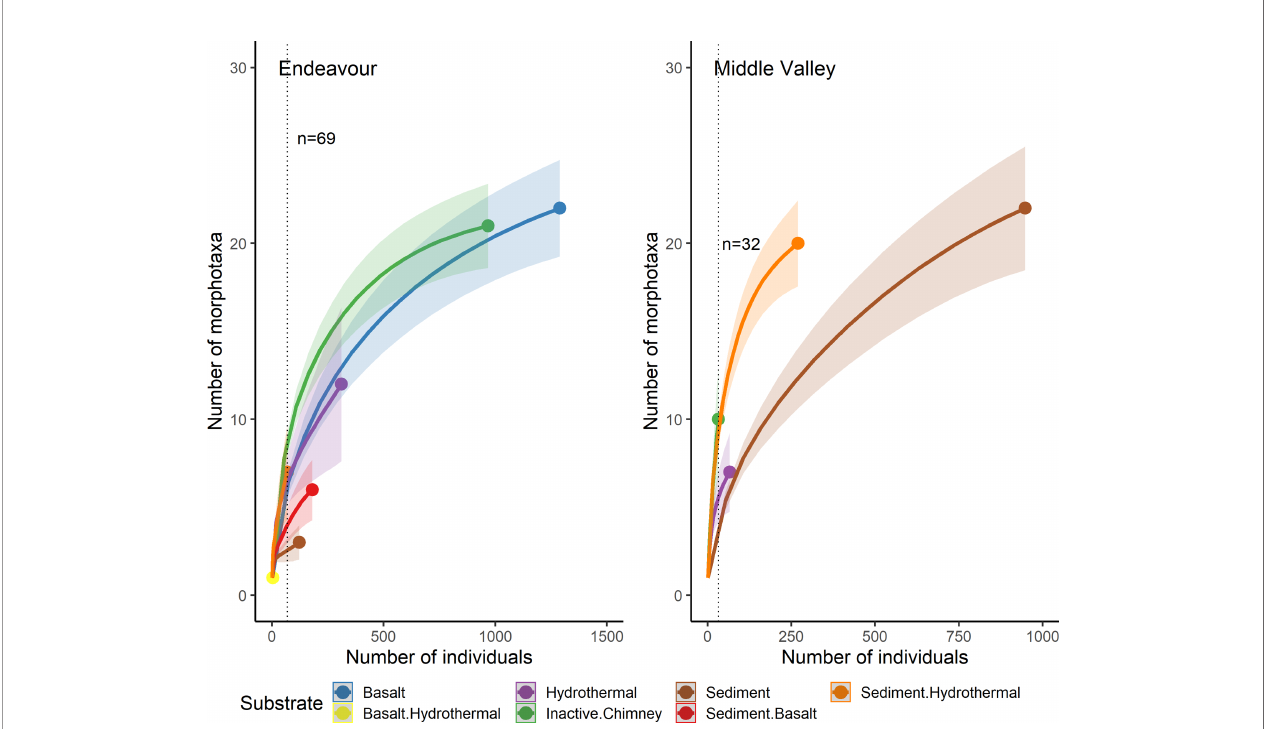
FIGURE 11 | Individual-based rarefaction curves for each substrate type, pooled across all dives sampled at Endeavour (R1938, R1939, R1940 and R1941) and Middle Valley (R1942 and R1943) on the Juan de Fuca Ridge, NE Paci fi c. “ Hydrothermal ” substrate refers to inactive substrate that is hydrothermally derived. The substrate ‘ basalt/hydrothermal ’ was omitted from the rarefaction analysis because only 3 individuals of a single morphotaxon were